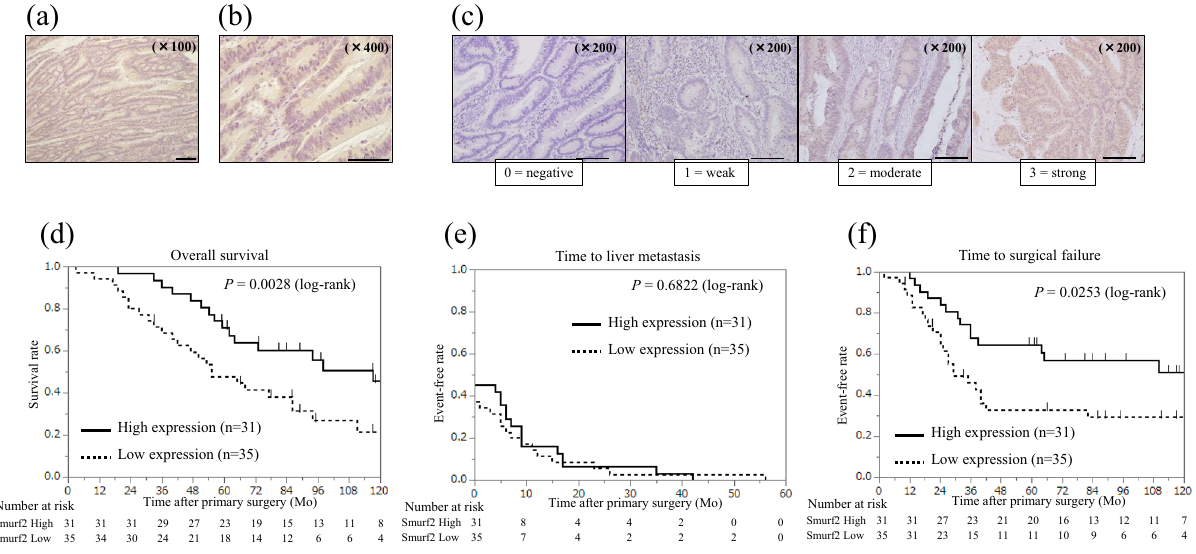
Figure 1. Smurf2 expression in primary CRC and the long-term outcome based on the Smurf2 expression. Immunohistochemistry analysis for Smad ubiquitination regulatory factor 2 (Smurf 2) expression in ( a , b ) primary colorectal cancer (CRC). Scale bar = 200 µm (a) and 100 µm ( b ). ( c ) Representative images of each score evaluating Smurf2 expression in primary CRC. Scale bar = 200 µm ( c ). The Kaplan–Meier analysis for ( d ) overall survival, ( e ) time to liver metastasis, and ( f ) time to surgical failure based on the Smad ubiquitination regulatory factor 2 (Smurf 2) expression in primary CRC.